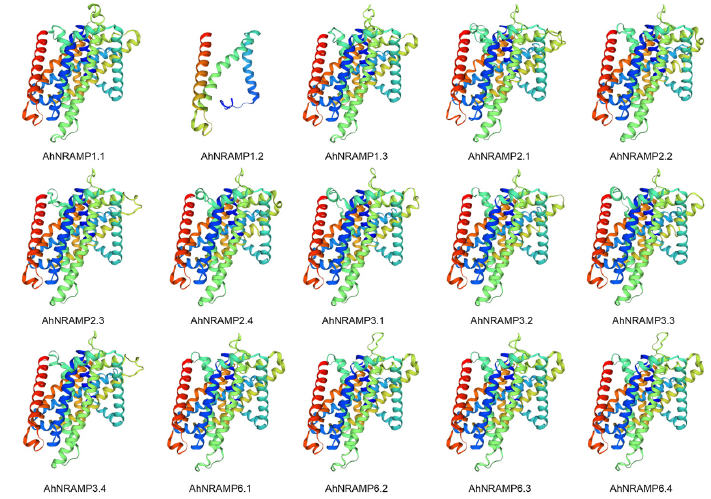
Figure 4. Predicted 3D structure of peanut AhNRAMP proteins by SwissModel. Models were visu- alized by rainbow color from N to C terminus.